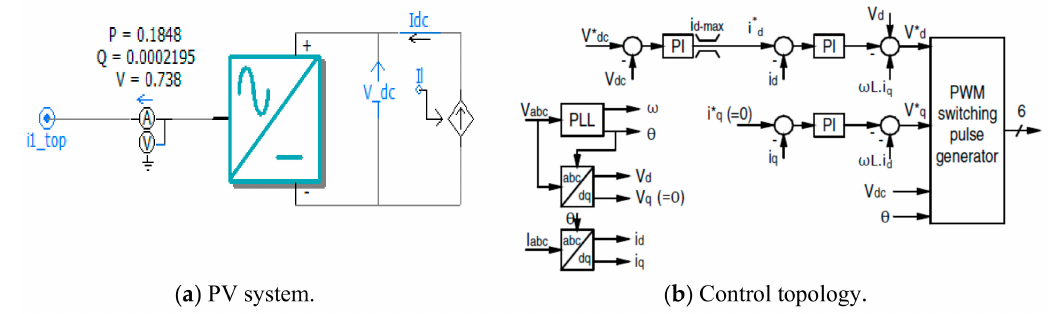
Figure 8. Photovoltaic system